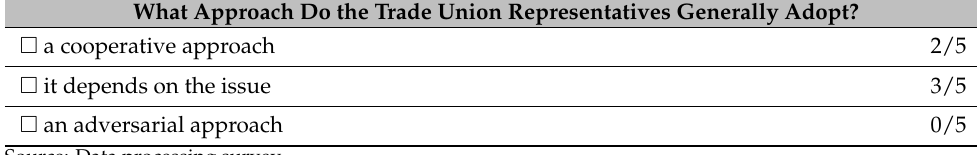
Table 6. Trade union representative approach.